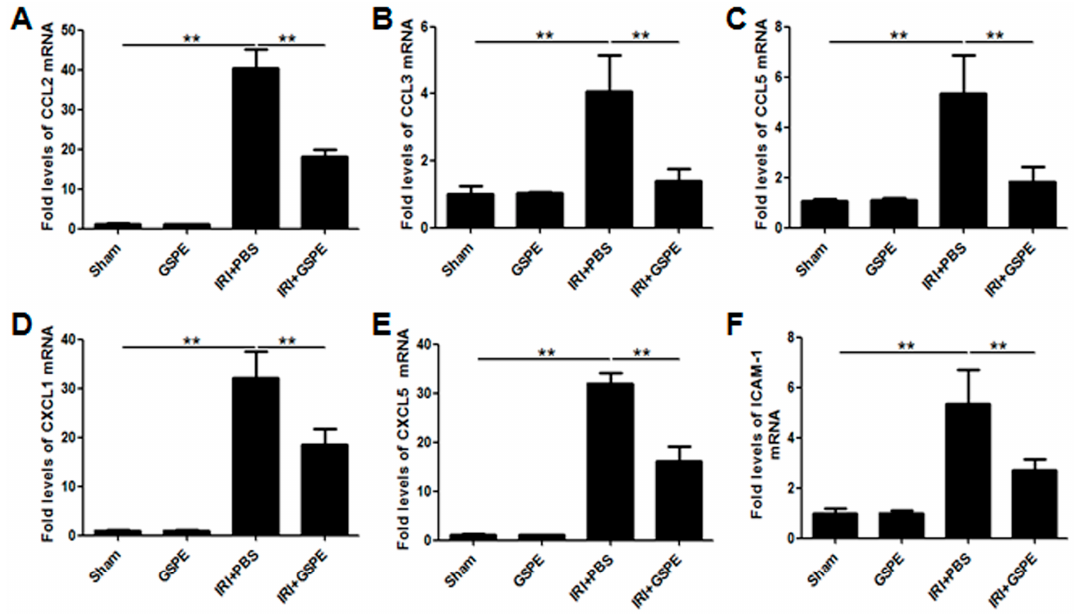
Figure 3. GSPE pretreatment inhibits the release of chemokines. The amplification of inflammation was measured by the mRNA expression of CCL2 ( A ), CCL3 ( B ), CCL5 ( C ), CXCL1 ( D ), CXCL5 ( E ) and ICAM-1 ( F ). The data shown are mean ±SEM (** p < 0.01; n = 7 per group).